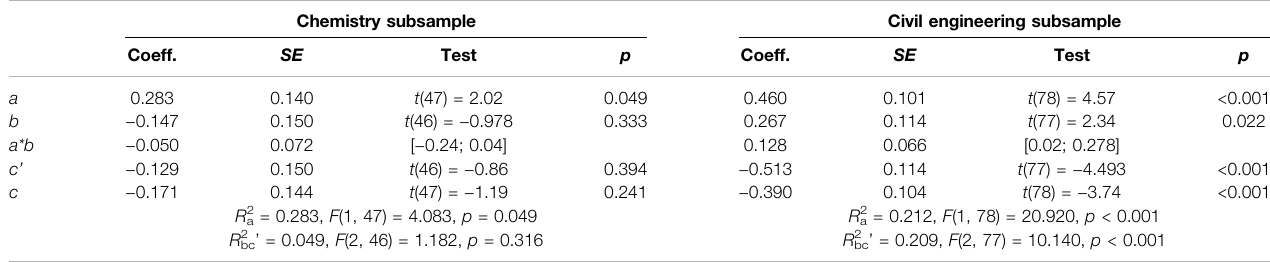
TABLE 6 | Detailed results of the mediation analysis between group awareness (predictor), successful academic help-seeking (mediator) and students ’ dropout intention (criterion).